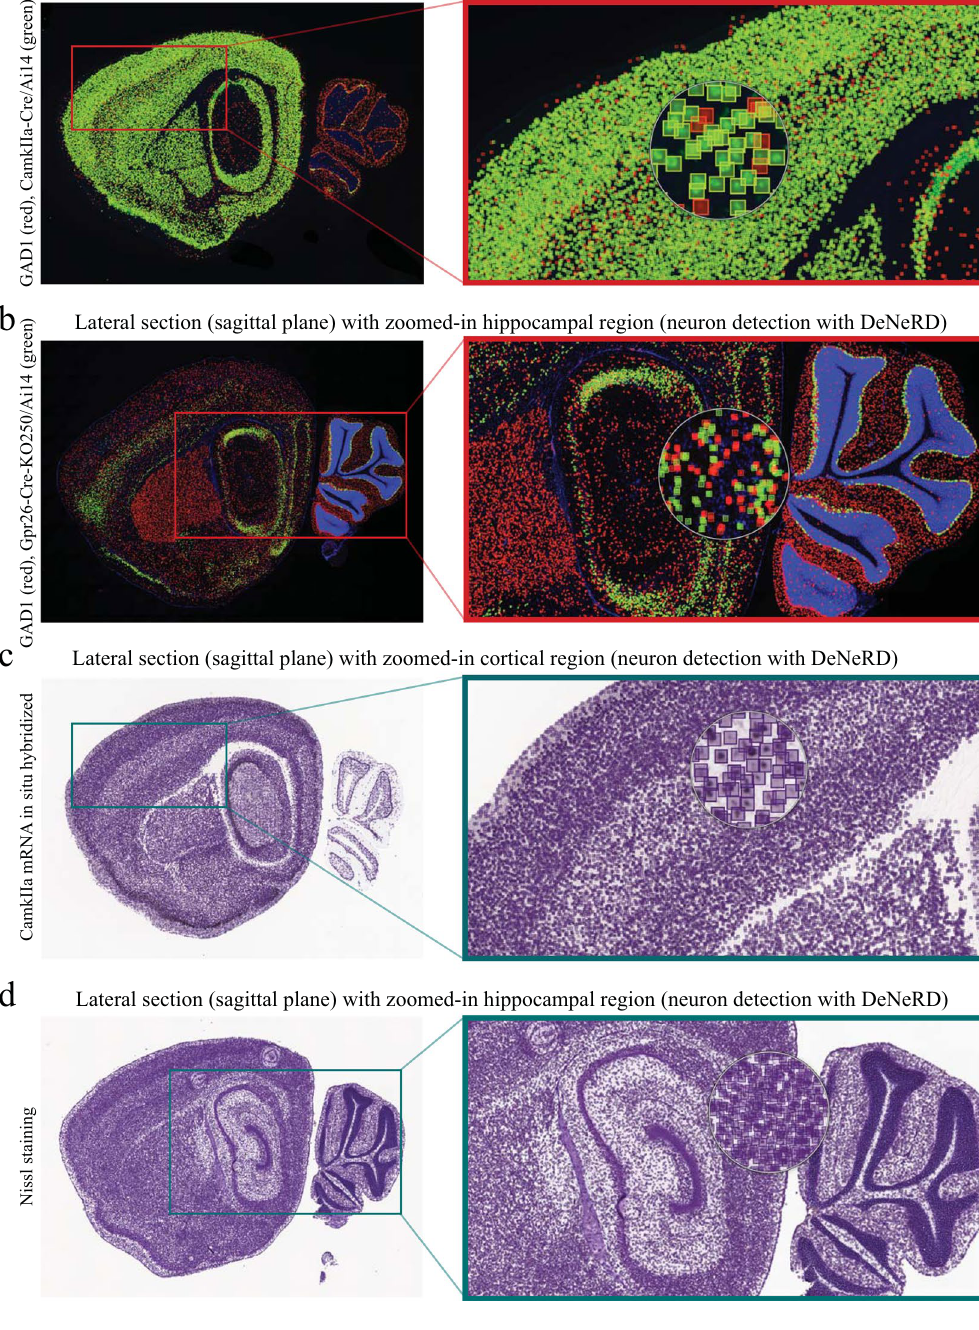
Figure 5. Assessing the performance of DeNeRD in detecting neurons in images of adult brain sections labeled neurons with a variety of brain markers taken with bright field and fluorescent microscopy at a sagittal plane. ( a ) The results obtained with DeNeRD in detecting a variety of neurons fluorescently labeled with GAD1 tdTomato (red) and CamkIIa-Cre/Ai14 (green) in a lateral image of a sagittal postnatal (P) 77 female mouse brain section. The red box is the area shown as zoomed-in on the right side. Further zoom is shown with the detected cells and their bounding boxes in the granular and infragranular cortical layers. ( b ) Performance of the Deep Neural Network (DNN) in detecting neurons labeled for GAD1 tdTomato (red) and Gpr26-Cre-KO250/Ai14 (green) in a P28 female brain section is shown. Zoom in on hippocampus and cerebellum is shown with the performance of deep neural network in neuron detection. ( c ) Lateral section from a CamkIIa-stained adult brain, labelling pyramidal neurons with the DNN detections on top. Zoomed-in sample is shown with purple bounding boxes for neuron detection in cortical region. ( d ) Nissl-stained adult (P56) brain section, labeling all neurons is shown, together with the DNN detections (purple bounding boxes) on top. Zoomed-in image is shown with the performance of deep neural network in detecting neurons in hippocampal region. The original brain sections are obtained from 3 . Image credit: Allen